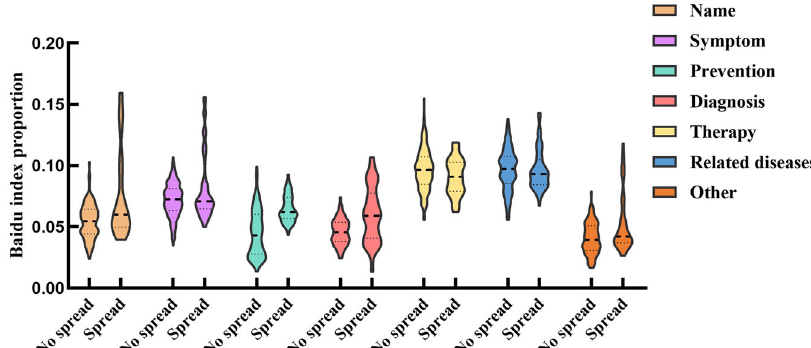
Fig. 4 Distribution comparison of various types of keyword search indexes. The distribution characteristics of various types of keyword search indexes in the transmission and nontransmission stages. The results show that the search index in the transmission stage has more outliers, and the search index in the transmission stage is signi fi cantly higher than that in the nontransmission stage, especially in the three categories of name, prevention, and diagnosis.